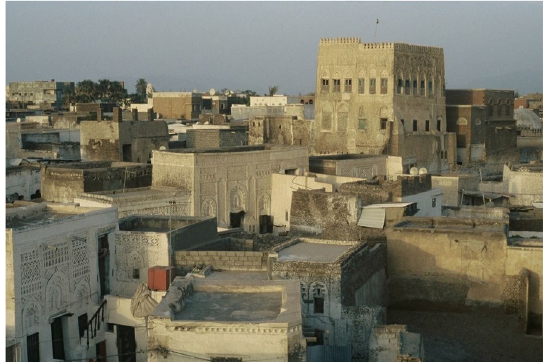
Fig. 2 Zabid, urban pattern with decorated historic façade (Source: the